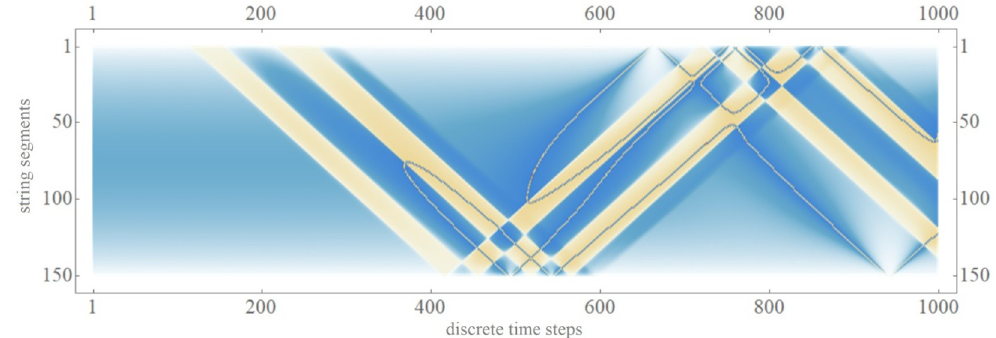
Figure 16 . Density plot of the deficit angle on the segmented string worldsheet. The quench creates two sinh-Gordon regions (shown in yellow). The time-evolution produces several cusp pairs, some of which annihilate. The parameters of the simulation are ∆ t = 4 , (cid:15) = 0 . 095 , with N